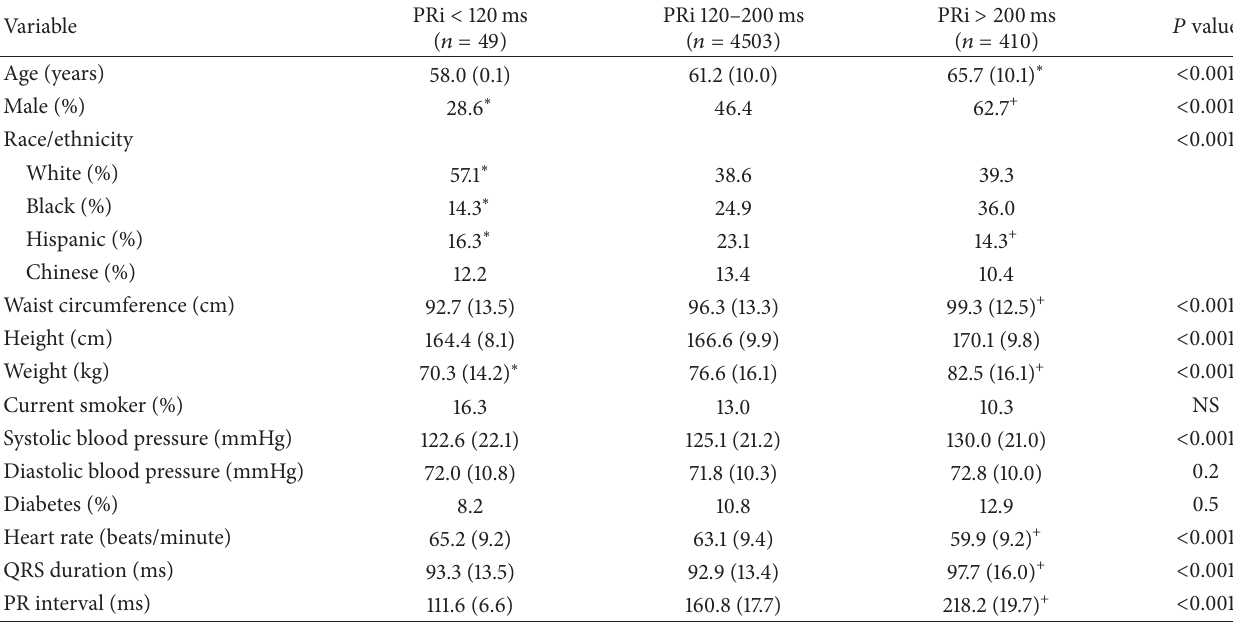
Table 1: Characteristics by presence of a prolonged PR interval